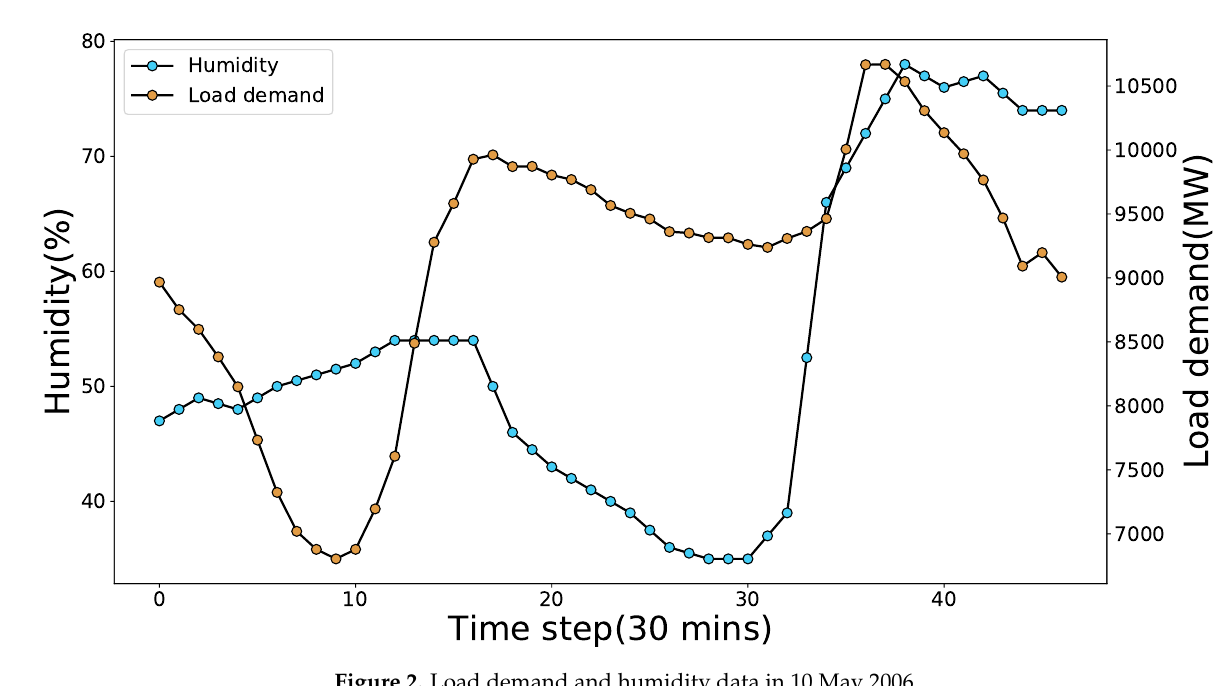
Figure 2. Load demand and humidity data in 10 May 2006.